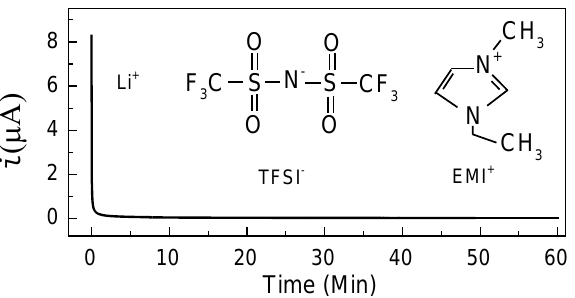
Figure 4. Direct current (DC) polarization plots of the SS/P-40-10/SS cell, recorded at room temperature under a voltage of 0.5 V (inset shows the chemical structures of TFSI − and EMI + ).